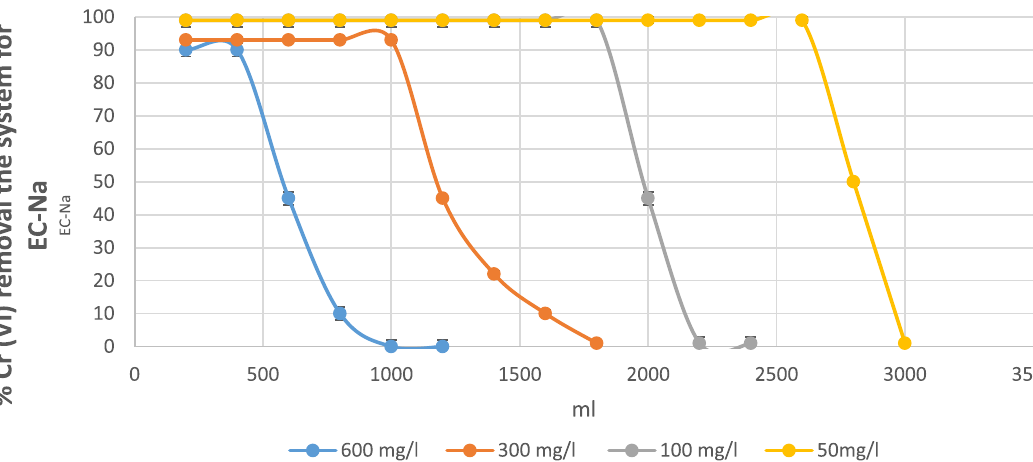
Figure 5. Percentages of Cr (VI) removal the system for